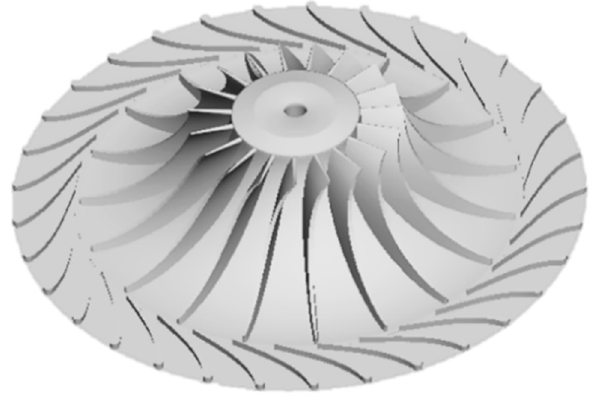
Figure 2. Overview of the designed radial inflow turbine.